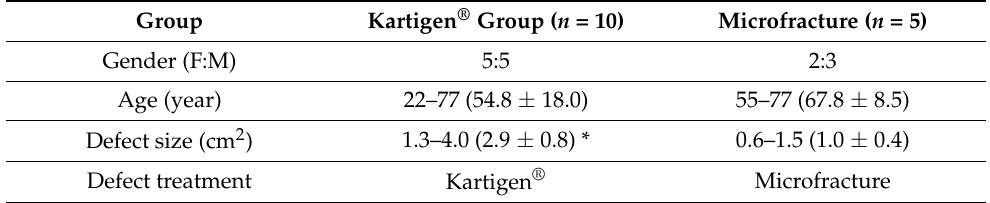
Table 1. Demography of the